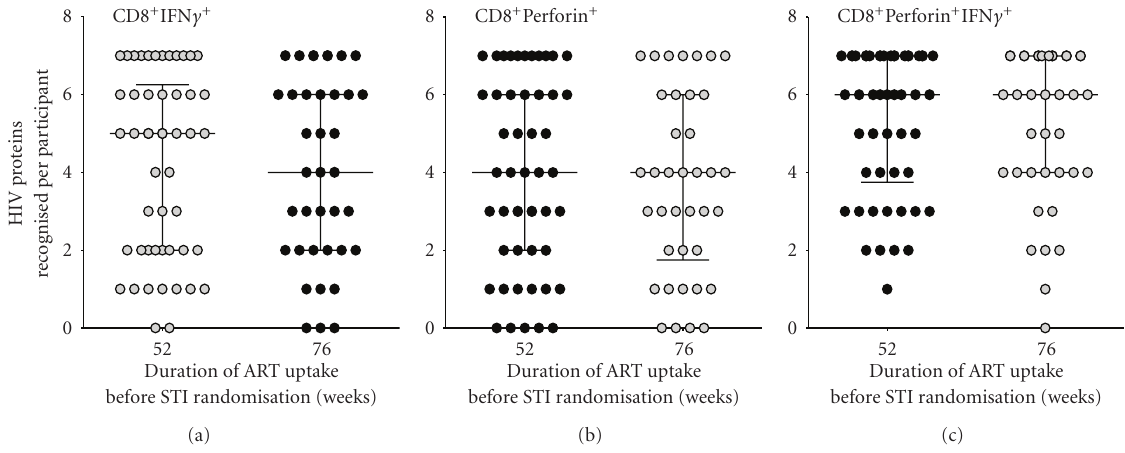
Figure 2: Relationship between breadth of HIV-specific CD8 + T-cell recognition at STI/CT randomization and the duration of pre-ART randomization. This figure evaluates whether ART uptake for either 52 weeks or 76 weeks preceding randomization had any influence on the breadths of HIV-specific (a) CD8 + IFN γ + , (b) CD8 + Perforin + , or (c) CD8 + IFN γ + Perforin + T-cell responses. Individual HIV peptides were grouped together in pools according to HIV protein. HIV-specific T-cell recognition was evaluated against these pools that were based on consensus sequences of HIV-1 Gag clades A (92UG037) and D (94UG114); and consensus sequences of HIV-1 clade B (Nef, Tat, Vif, Rev, Vpr, Vpu, and Pol). HIV-specific responses to Gag (clades A and D) were considered concomitantly. Breadth was defined as the number of HIV protein pools recognised per individual. Horizontal bars represent medians and interquartile